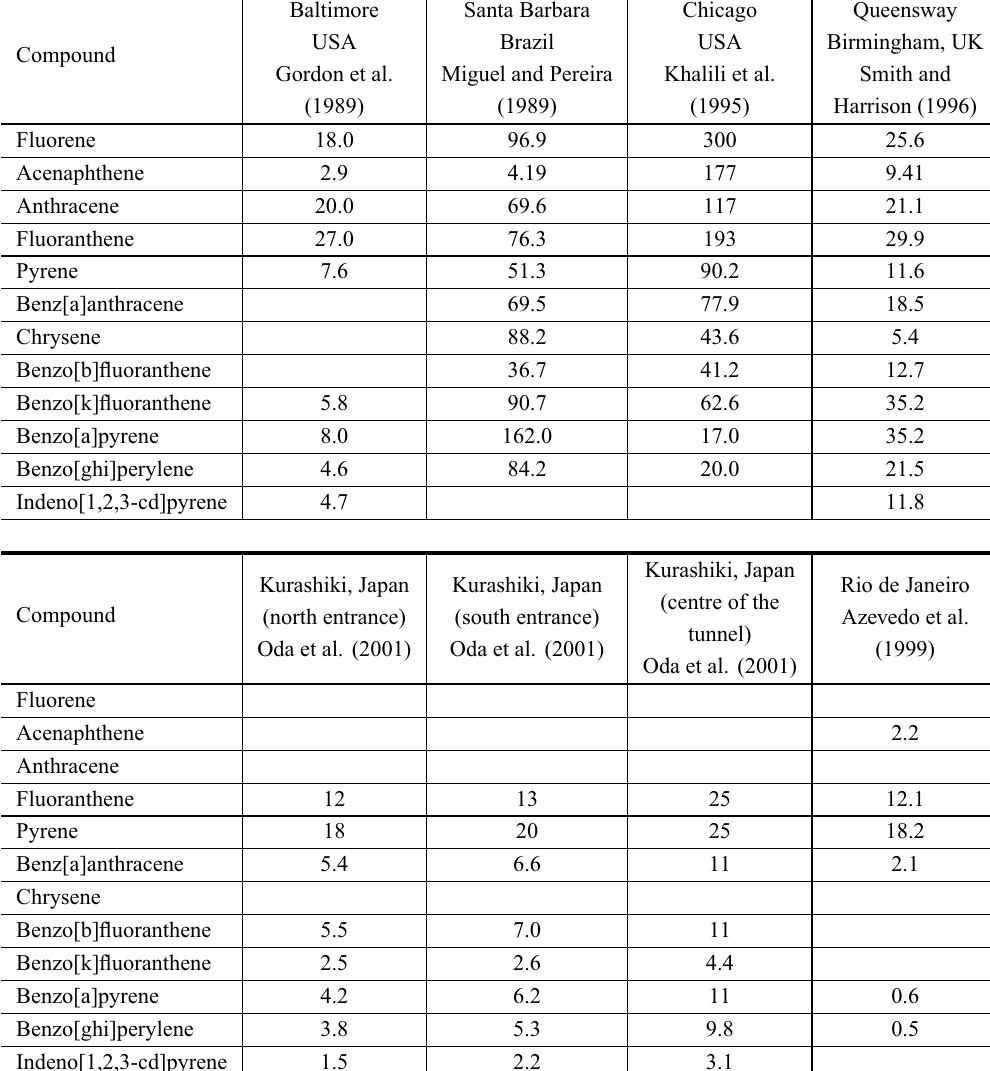
Comparison of PAH concentrations obtained at road tunnels throughout the world (ng m -3